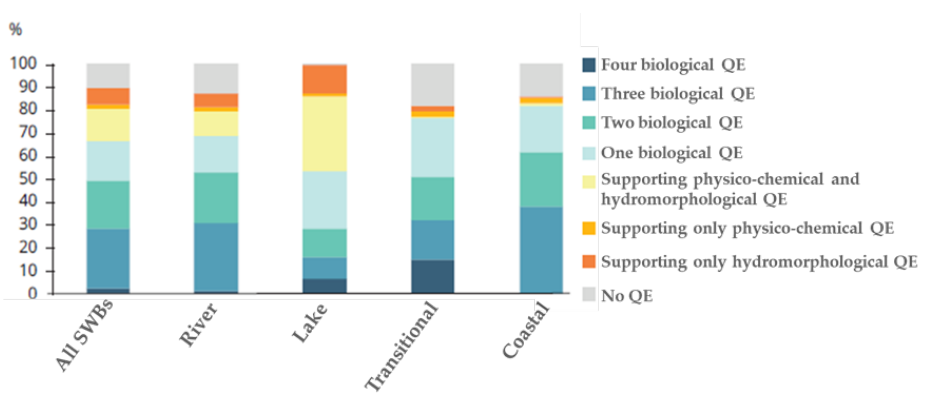
Figure 4. Percentage of classified water bodies using different QEs, according to the second RBMPs (source: [12]).